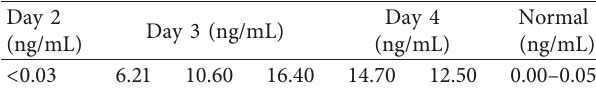
Figure 7: Coronary CT angiogram image revealing the right coronary artery arises normally from the right coronary cusp and is dominant without any evidence of coronary artery disease. Table 3: Troponin